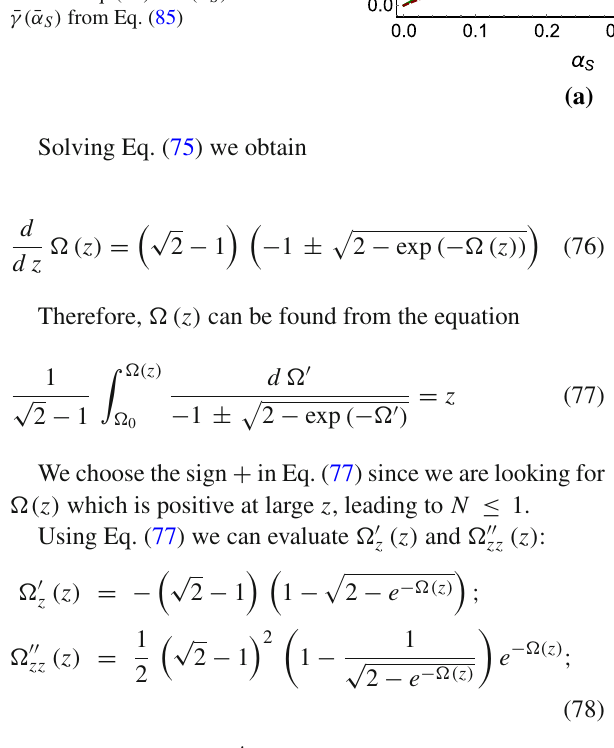
Fig. 5 a λ for Y dependence of the saturation scale: Q 2 s ( Y ) = Q 2 s ( Y = 0 ) exp (λ Y ) versus ¯ α S . The solid line corresponds to λ = 4 ¯ α S in LO DLA, dashed green curve describes the NLO DLA (see Eq. (22)) and the dashed red curve is Eq. (72). b λ( ¯ α S ) and ¯ γ( ¯ α ) from Eq. S